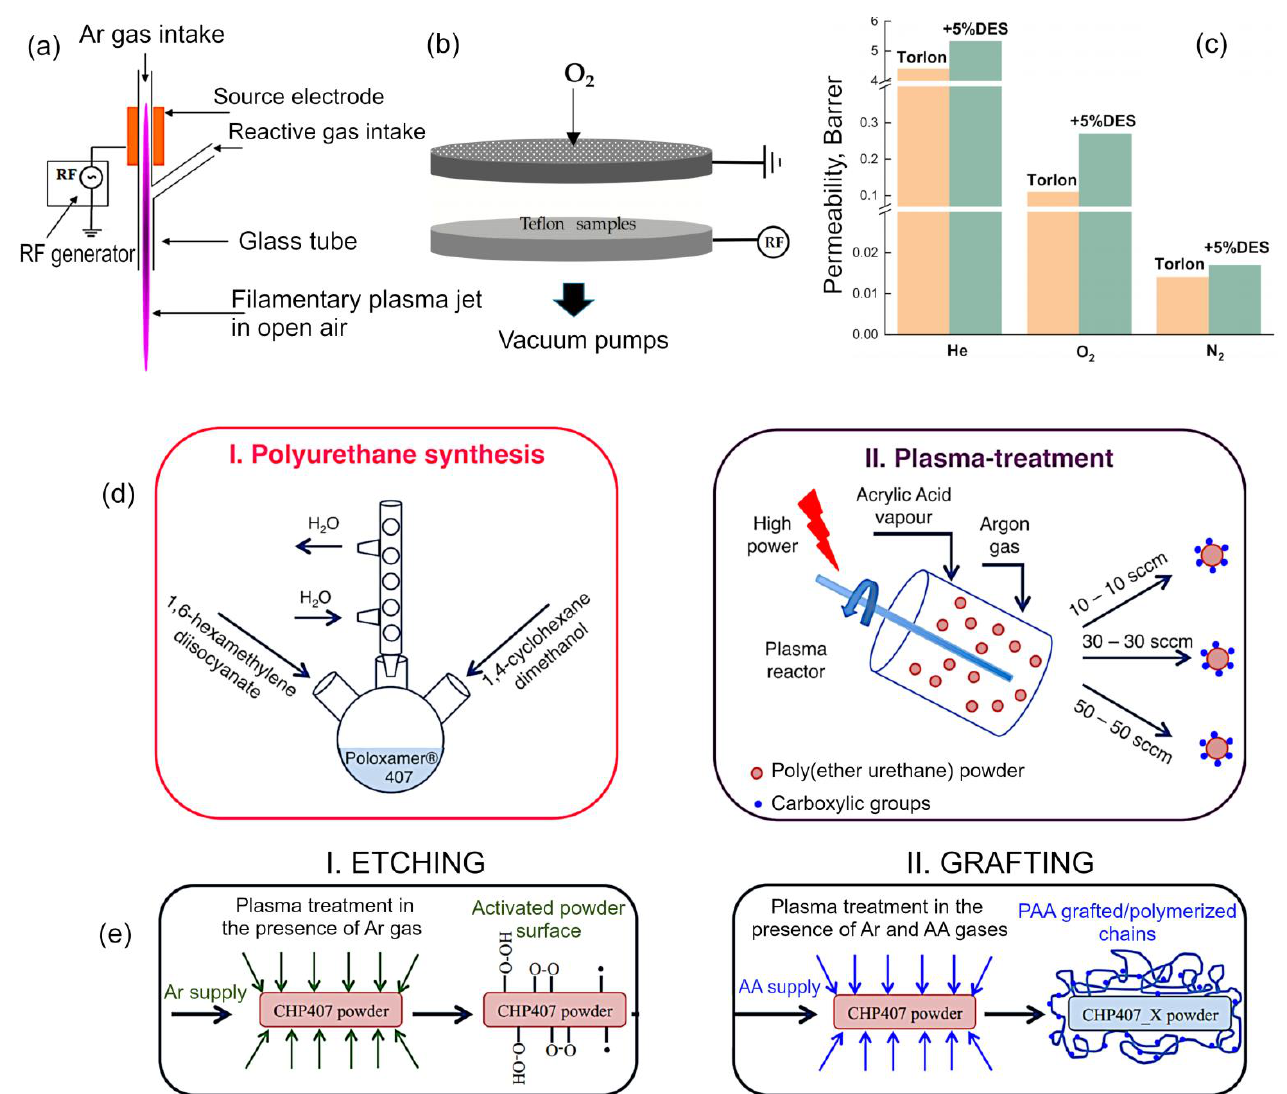
Figure 7. ( a ) Configuration of the dielectric barrier discharge Y-shaped source. Reproduced from Panaitescu et al. (2020) [73] under conditions of the CC BY license. ( b ) Scheme of the electrode system of the plasma reactor setup used for plasma nano/microtexturing of Teflon samples. The upper electrode is a shower-head type to allow homogeneous feed of the process gas (O 2 in this case). Samples are placed on the bottom electrode, which is radio-frequency (RF) powered. Reproduced from Mundo et al. (2017) [74] under conditions of the CC BY license. ( c ) Permeability of Torlon and Torlon/DES-5 composites for He, N 2 , and O 2 at 30 °C. Reproduced from Pulyalina et al. (2021) [75] under conditions of the CC BY license. ( d ) Schematic representation of the two main steps needed for the design of an amphiphilic poly(ether urethane) exposing a tunable amount of carboxylic groups: (I) polyurethane synthesis; (II) powder plasma treatment. ( e ) Schematic represen- tation of the plasma treatment process: (I) etching phase in the presence of Ar gas to create free radicals on powder surface and (II) grafting step in the presence of Ar gas and acrylic acid vapors to expose carboxylic groups. Reproduced from Laurano et al. (2019) [80] under conditions of the CC BY license.